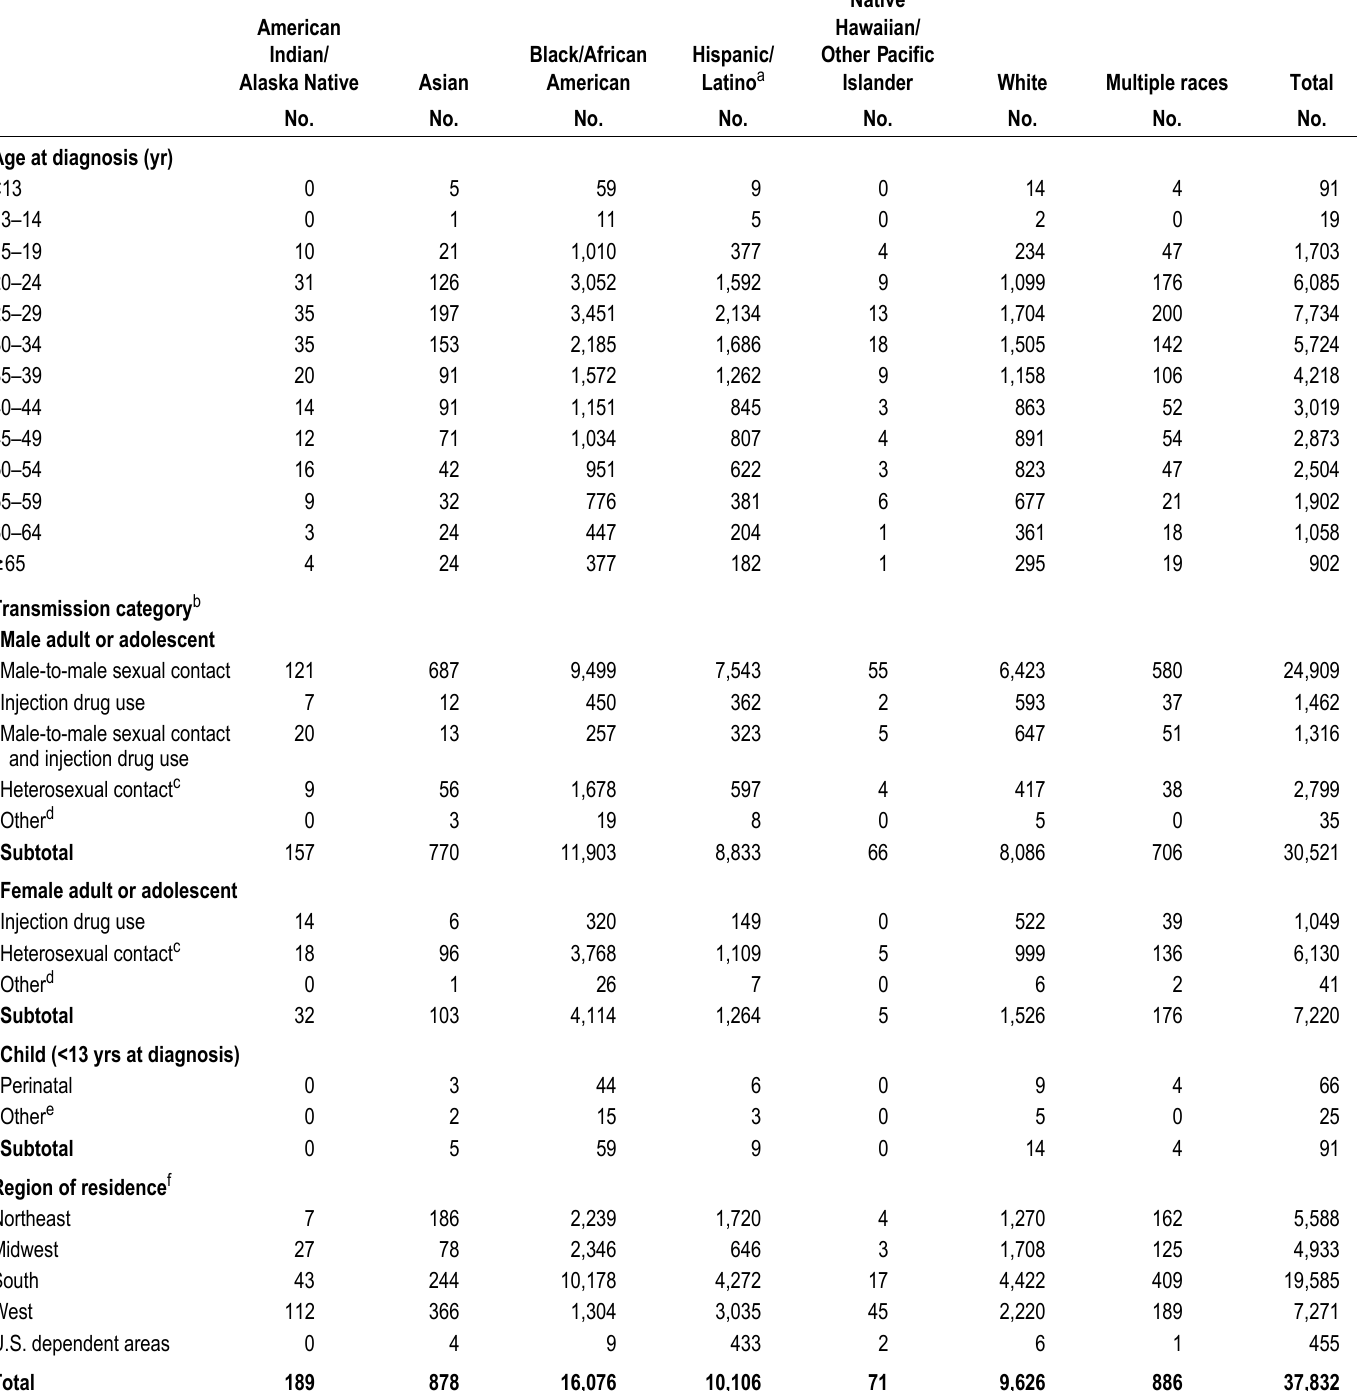
Table 3b. Diagnoses of HIV infection, by race/ethnicity and selected characteristics, 2018—United States and 6 dependent